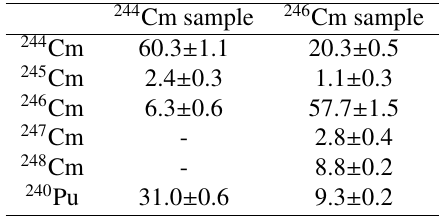
Table 1. Isotopic composition (% atoms) of the 244 Cm and 246 Cm